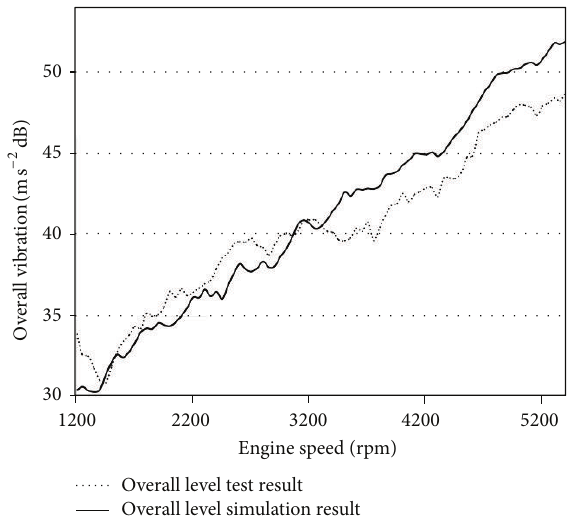
Figure 7: Dynamic mount stiffness derived by